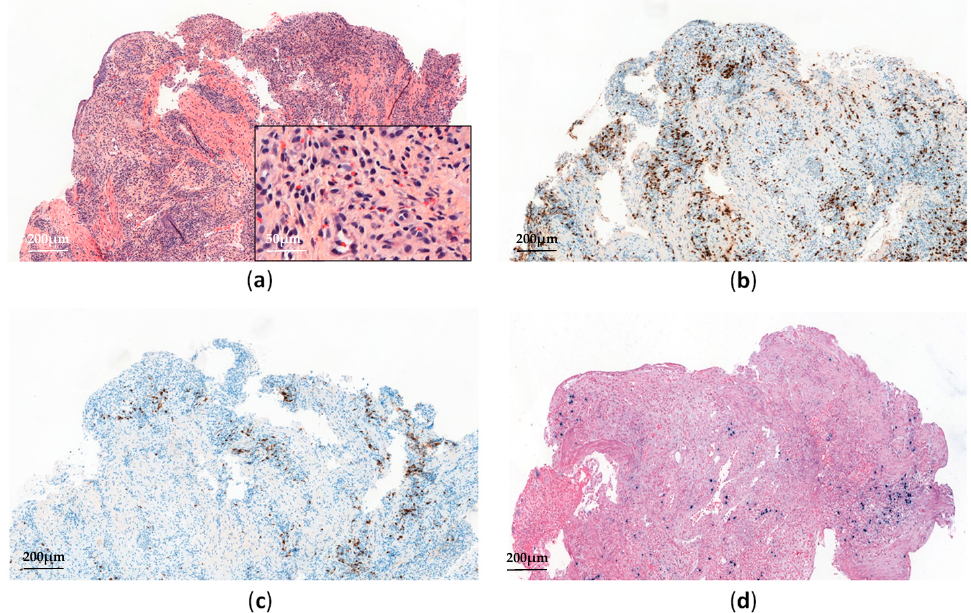
Figure 2. Systemic chronic active EBV infection involving the gastrointestinal tract: ( a ) Esophagus biopsy shows a polymorphic inflammatory infiltrate with a predominance of non-atypical small lymphocytes (H&E, × 60 and × 300); ( b ) The lymphoid infiltrate contains a predominance of CD3+ T-cells ( × 60); ( c ) Anti-CD20 immunostaining shows scattered reactive B-cells ( × 60); ( d ) EBV-encoded small RNA (EBER) in situ hybridization shows scattered positive cells ( ×